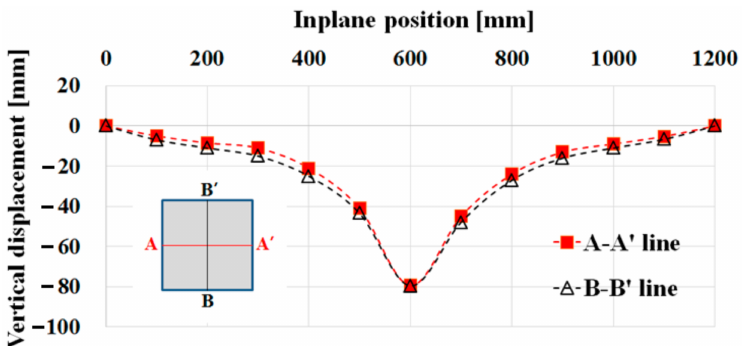
Figure 14. Vertical displacement of the drop impact experiment (drop height of 3 m).